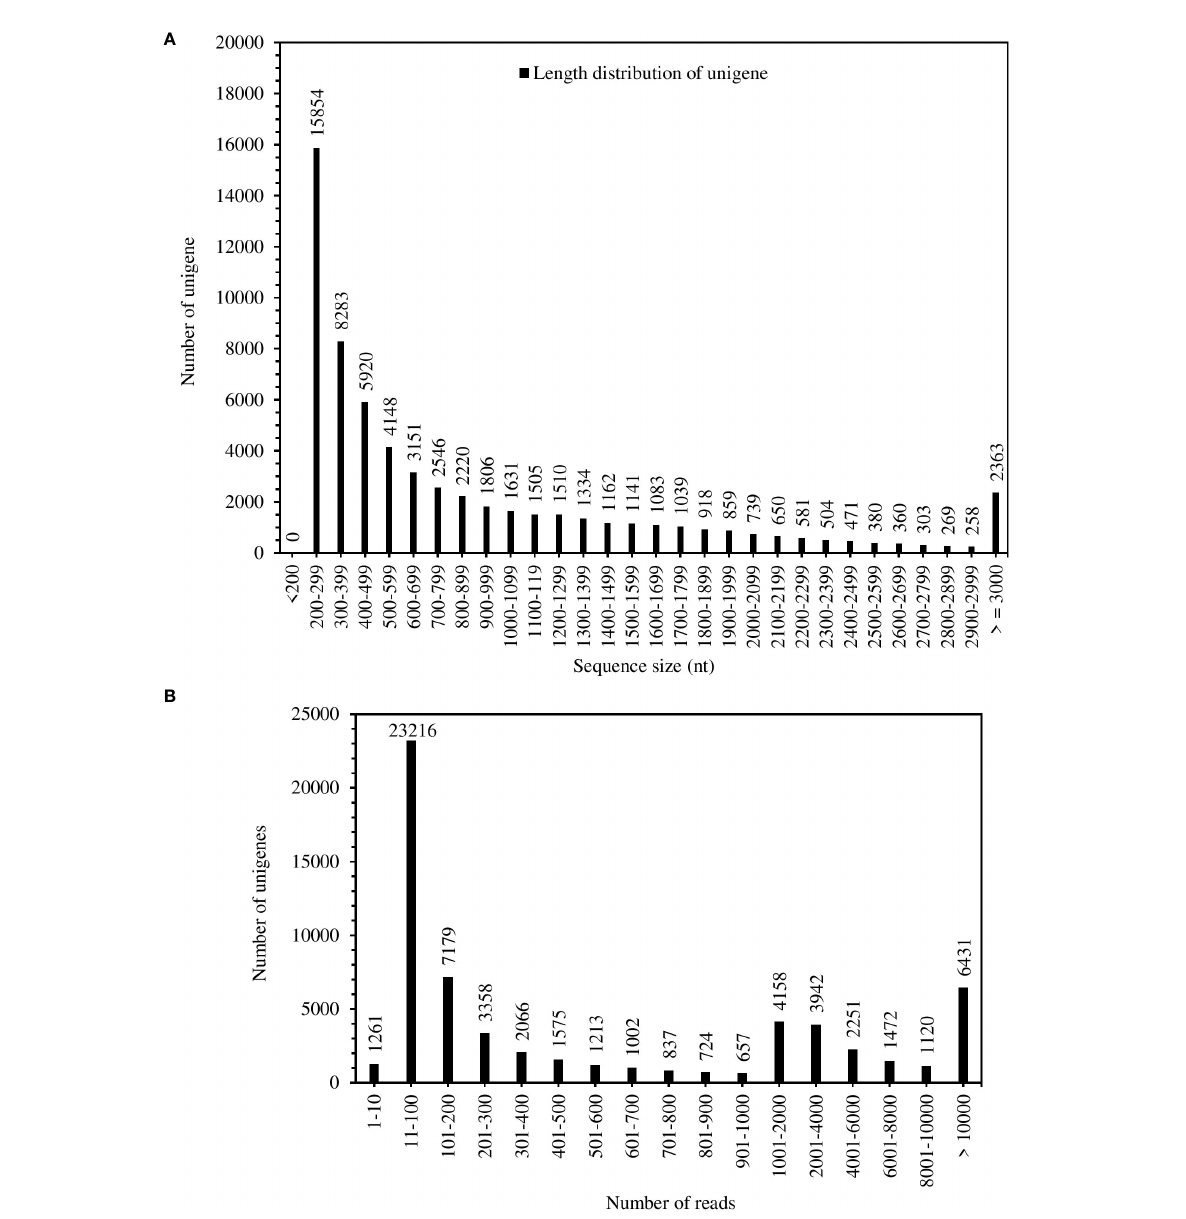
FIGURE 1 Unigenes length distribution (A) and coverage statistics (B) of S. spontaneum